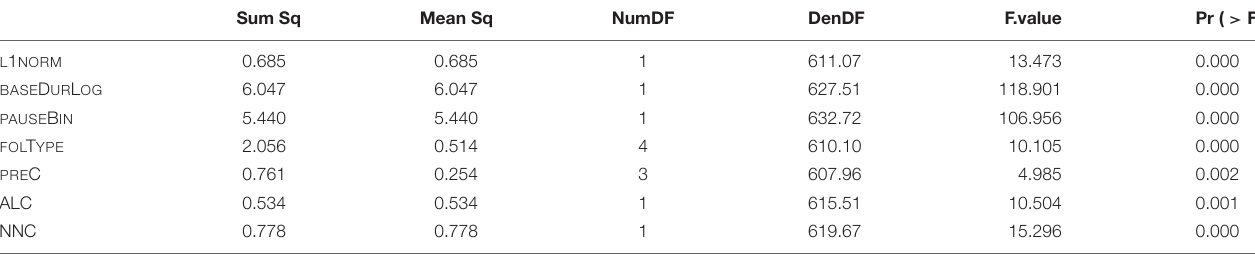
TABLE 8 | p -values of fixed effects in the final “LDL measures only” model, fitted to the log-transformed durations of S. Sum Sq Mean Sq NumDF DenDF F.value